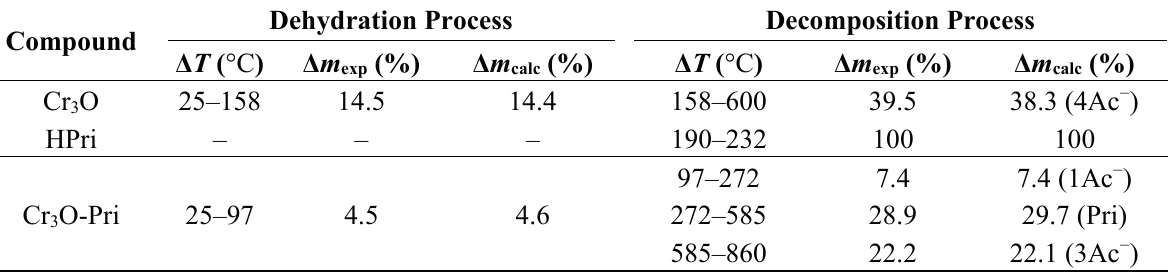
Table 1. Thermogravimetric data for the starting compounds [Cr 3 O(CH 3 CO 2 ) 6 (H 2 O) 3 ]Cl (Cr 3 O) and primuletin (HPri), and the product complex [Cr 3 O(CH 3 CO 2 ) 6 (Pri)(H 2 O) 2 ] (Cr 3